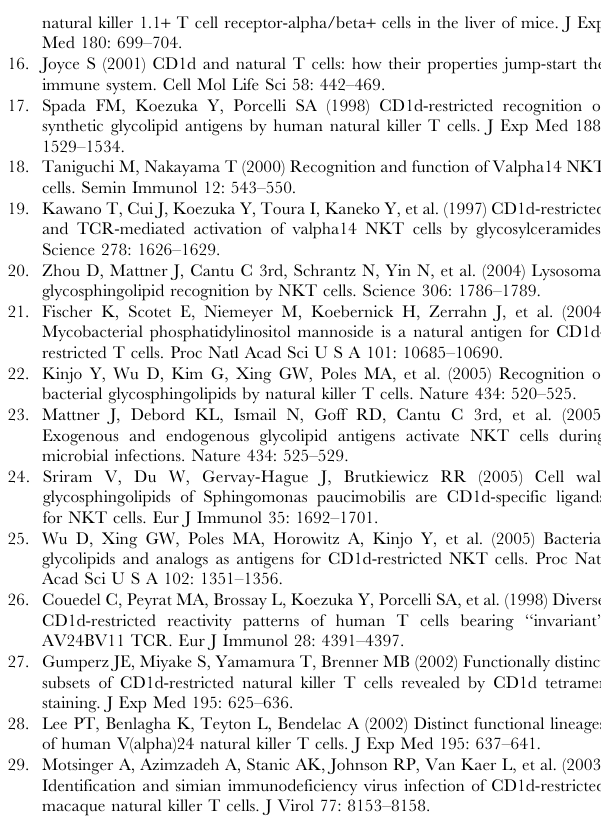
Figure S1 Cytokine polarization of CB CD4 + Th cells. CB CD4 + T helper cells were activated under Th0- Th1- or